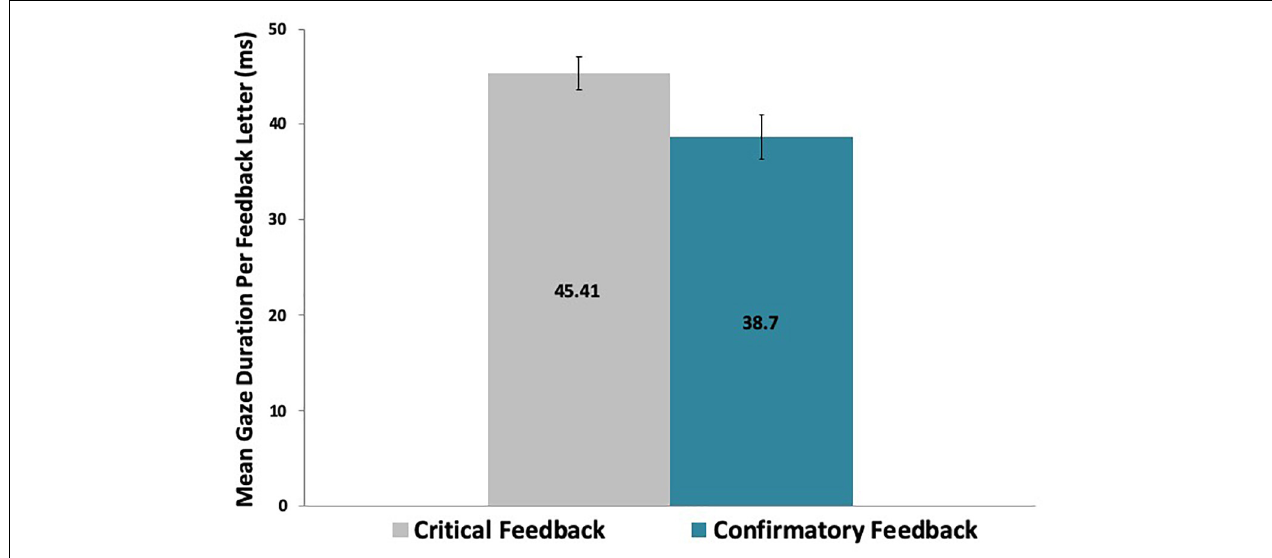
FIGURE 4 | Participants spent significantly more time dwelling on critical than on confirmatory feedback letters across the game.